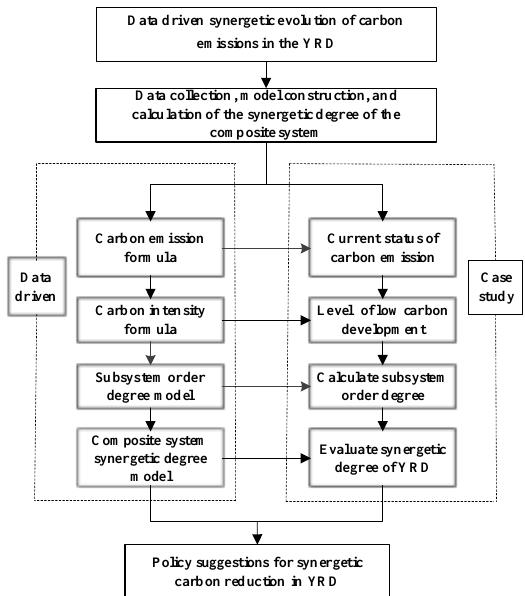
Figure 2. Schematic showing application of the proposed method to real data.